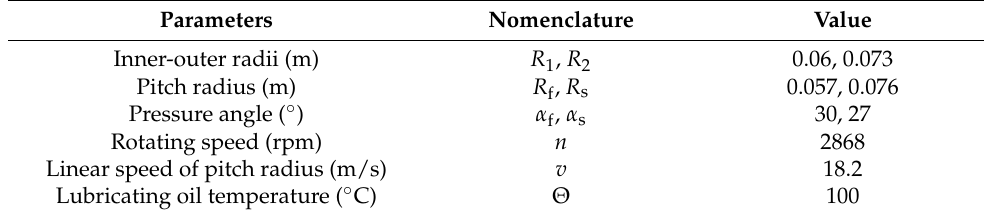
Table 1. Physical parameters of the friction